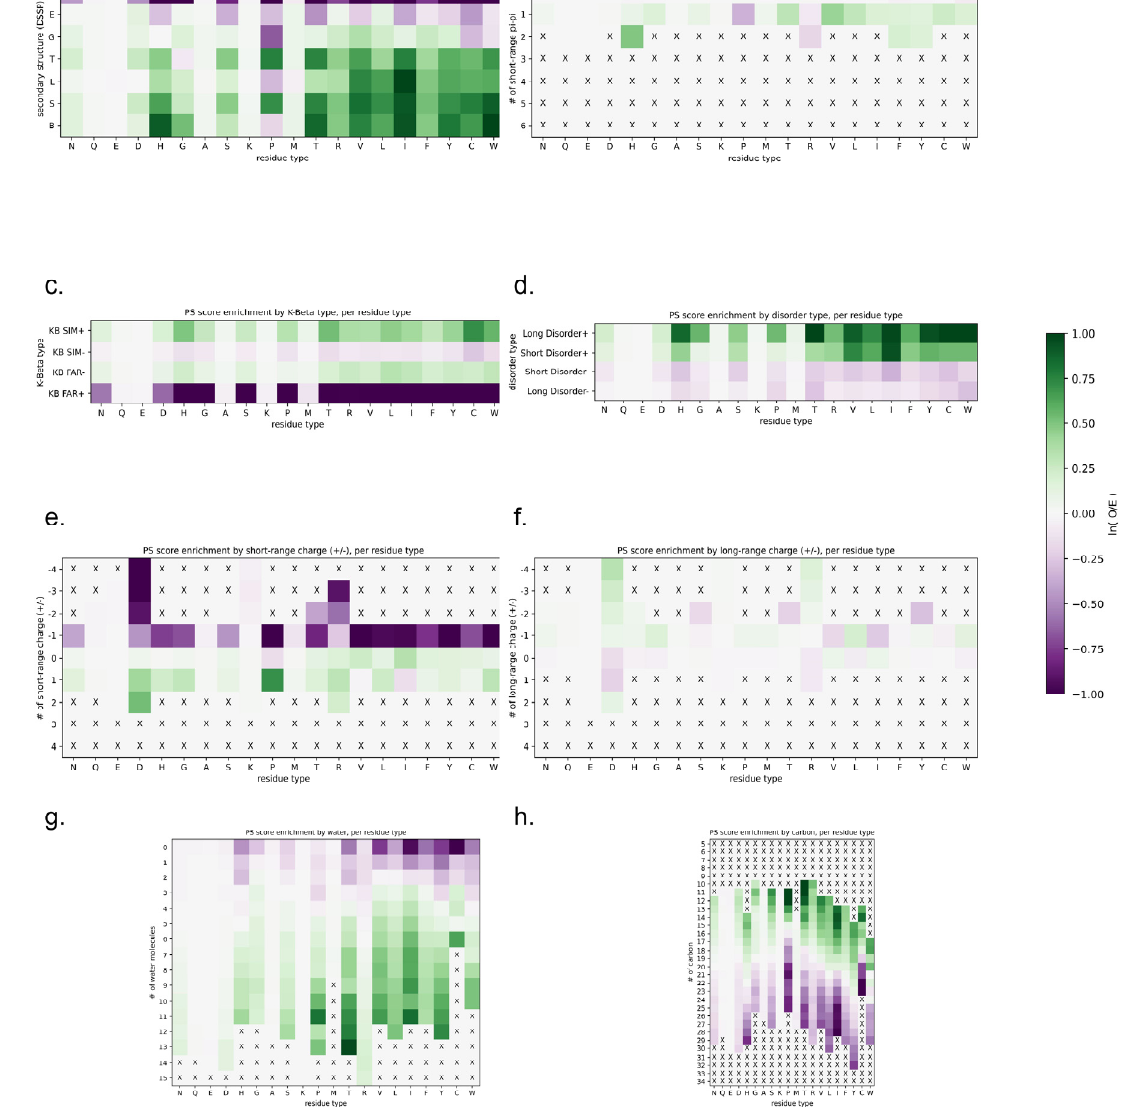
Figure 12. LLPhyScore score enrichment by eight selected physical features for the PDB proteome, per residue type, for the human + PDB model. Heatmaps show the score enrichment in PDB protein sequences by each feature’s discrete values, normalized to each residue type. The color gradient shows the natural logarithm of the observed over expected ratio. Enrichment for ( a ) secondary structure (H, alpha-helix; E, beta-sheet; G, 3 10 helix; T, hydrogen-bonded turn; L, loop; S, bend; B, single-pair beta-sheet), ( b ) short-range pi–pi, ( c ) K-beta, ( d ) disorder, ( e ) short-range electrostatic, ( f ) long-range electrostatic, ( g ) protein–water and ( h ) protein–carbon. The color bar for all heatmaps is shown at the